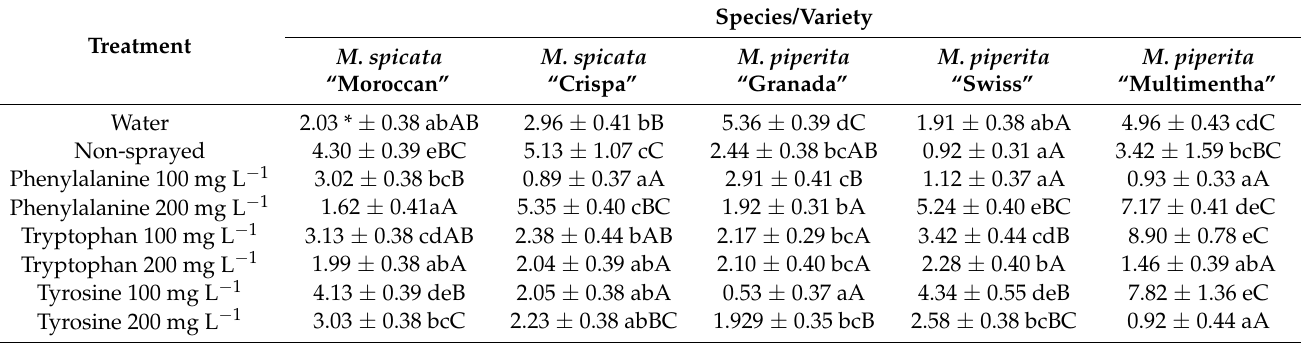
* Means ± standard deviations marked with different upper letters (A, B, C . . . ) in the rows are significant different at p < 0.05; Means ± standard deviations marked with different lower letters (a, b, c . . . ) in the columns are significant different at p < 0.05.